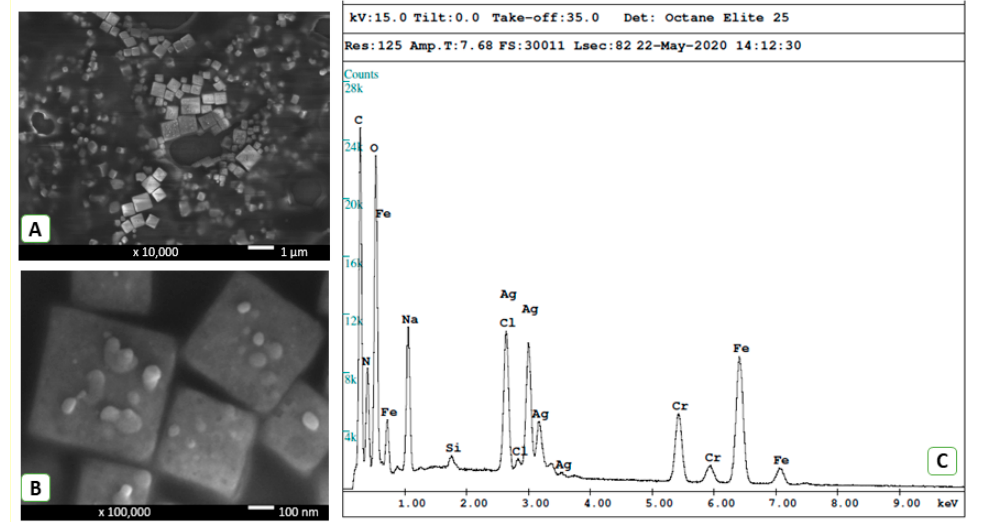
Figure 1. Scanning electron microscopy images of silver nanoparticles at 10,000 × ( A ) and 100,000 × ( B ) magnification coupled with the EDX pattern ( C ) obtained for a colloidal mixture.